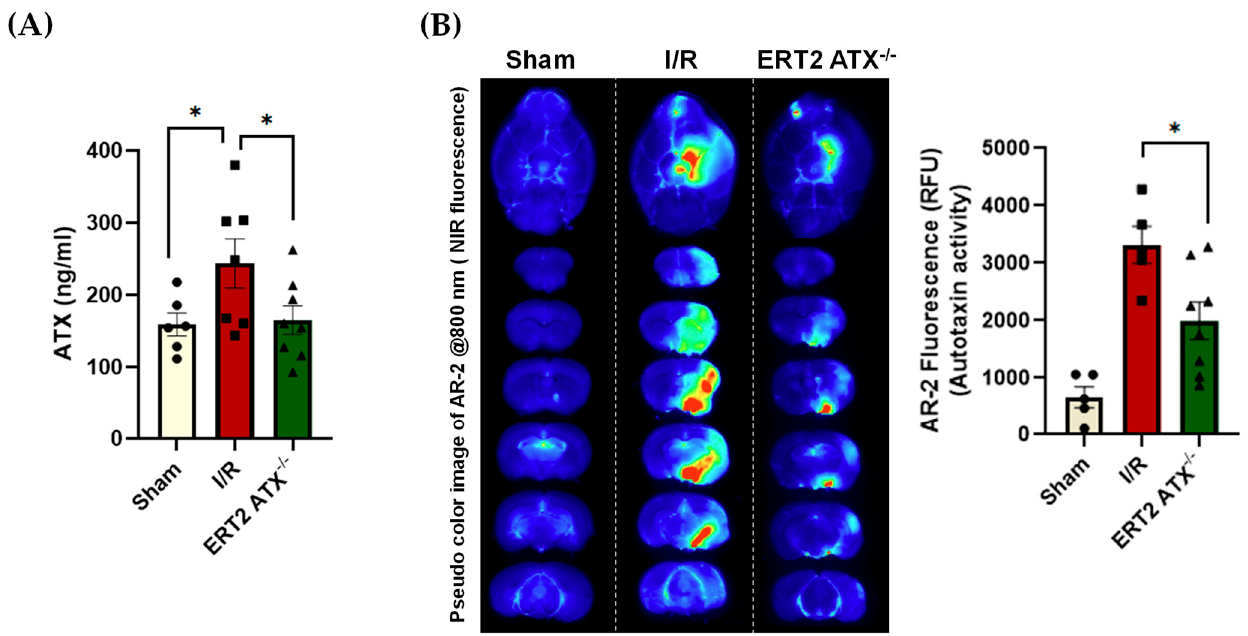
Figure 4 . Reduced ATX and its activity in ERT2 ATX − / − following I/R. ( A ) ATX concentration in mice plasma quantified using the ELISA kit in sham, I/R, and ERT2 ATX − / − mice, n = 6–8. ( B ) Enzymatic activity for ATX measured using the AR-2 fluorescence probe and quantified as relative fluorescence units (RFU) in sham, I/R, and ERT2 ATX − / − mice brains. Pseudo-color images of the AR-2 probe at 800 nm in an infrared imager are shown as representative images for ATX activity, n = 5–8. All values are mean ± SEM. * p < 0.05 shows significance compared using ANOVA followed by the Bonferroni post hoc test.